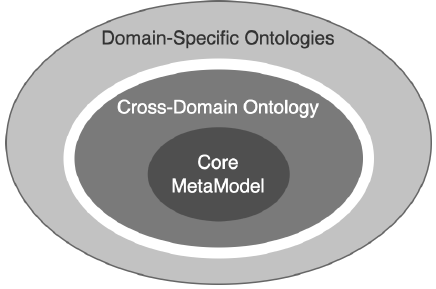
Figure 5. NGSI-LD Information